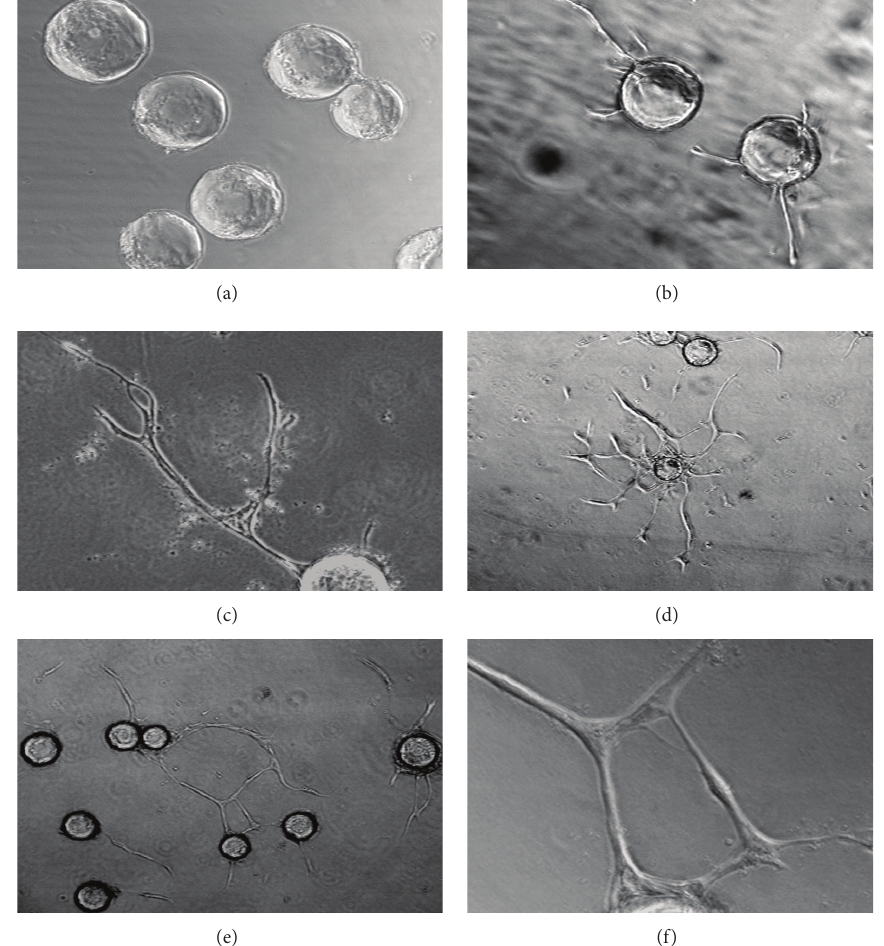
Figure 3: Formation of angiogenic sprouts and capillary tube-like structures by HDMEC in fibrin stimulated by VEGF (30ng/mL) and bFGF (25ng/mL). (a) In control fibrin gel without addition of angiogenic factors, no significant sprout formation occurred after 48hr. (b) In the presenceofVEGF(30 ng/mL)andbFGF(25ng/mL),HDMECformedangiogenicsprouts,andinvadedandmigratedintothefibringelwithin 48hr. (c) By 5 days, VEGF and bFGF stimulated HDMEC forming branching capillary tube-like structures in the fibrin gel. (d) Formation of local capillary arcades and networks by HDMEC in fibrin with VEGF and bFGF for 5 days. (e) Formation of wild capillary networks by HDMEC in fibrin with VEGF and bFGF for 5 days. (f) Higher magnification of a typical capillary network illustrates that networks formed as a result of branching and fusion of capillary tubes from neighboring beads. Magnification: (a), (b), and (c) 100x, (d) 40x, (e) 40x, and (f)